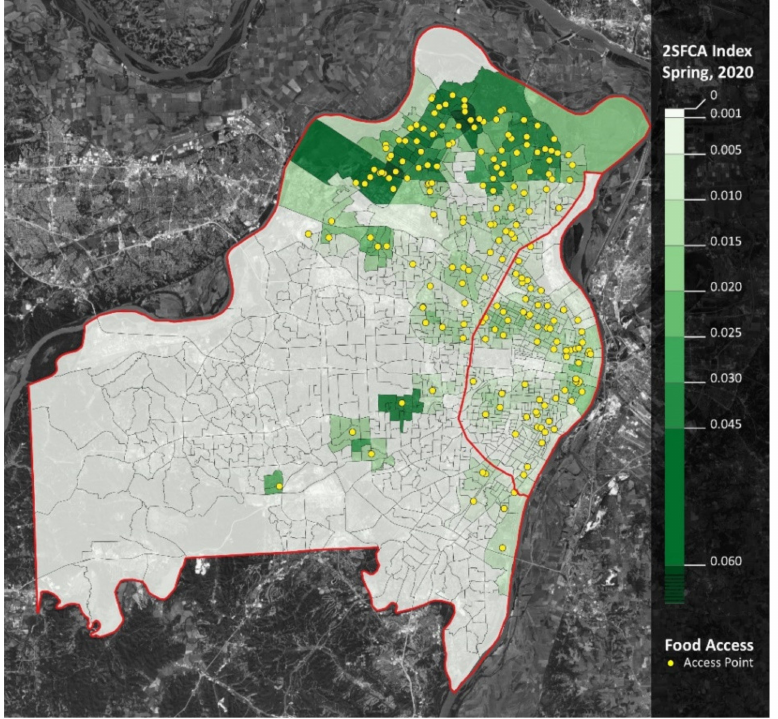
Figure 4. Meal accessibility (2SFCA Analysis): spring 2020. Notes: St. Louis City is the area east of Figures 5 and